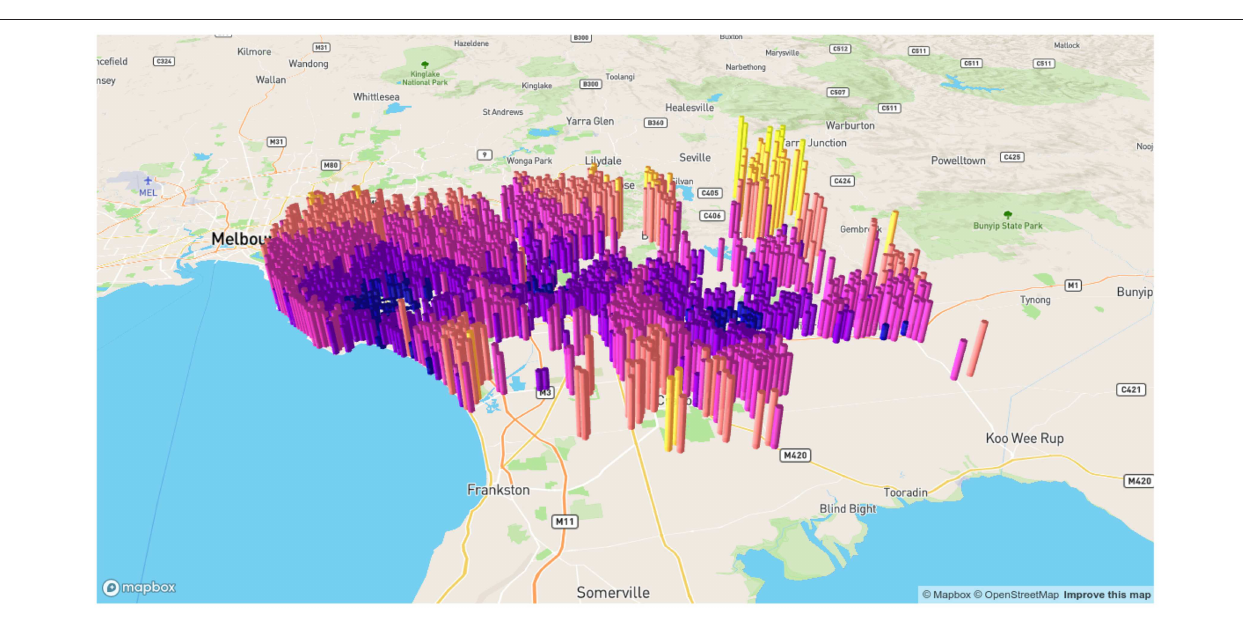
Frontiers in Neurology |